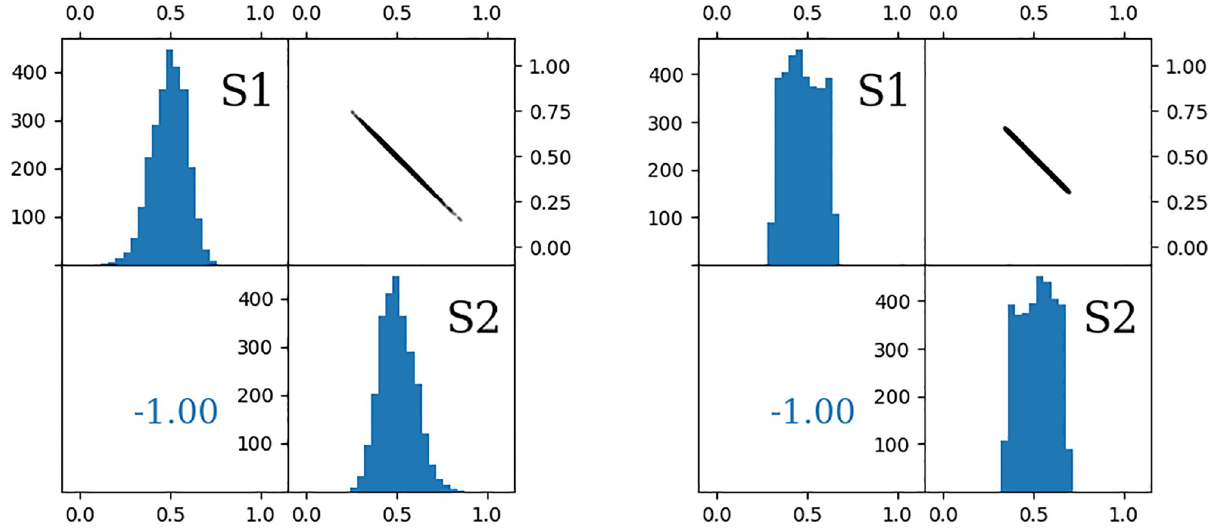
Fig 1. Results of FRAME calculation of two simple 1D examples: One treating the sources as points with uncertainties (left) and the other assuming their flat probability distribution with a certain range (right). Equal contribution of both sources was assumed and exact input values are listed in Table 1. The histograms on the diagonals shows distributions f 1 and f 2 built with the simulated Markov chains. The horizontal axis represents the values of f 1 , f 2 fractions and the vertical axis marks the number of counts (iterations). The top right panels show the scatter-plot of all entries, where abscissa is the value of f 1 and ordinate shows f 2 . The bottom left panel shows the correlation